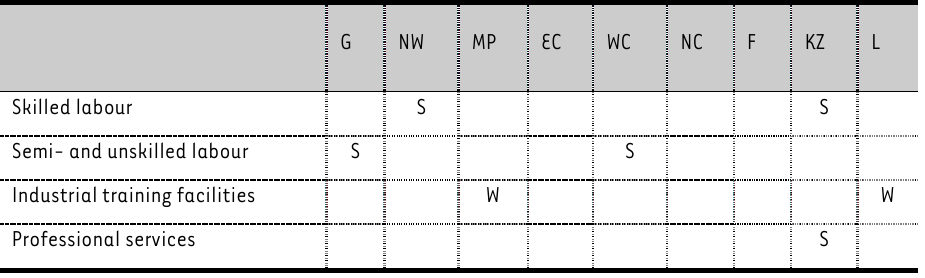
TABLE 3: Effect of Location on Competitiveness: Human Capital G NW MP EC WC NC F KZ L Skilled labour S S Semi- and unskilled labour S S Industrial training facilities W W Professional